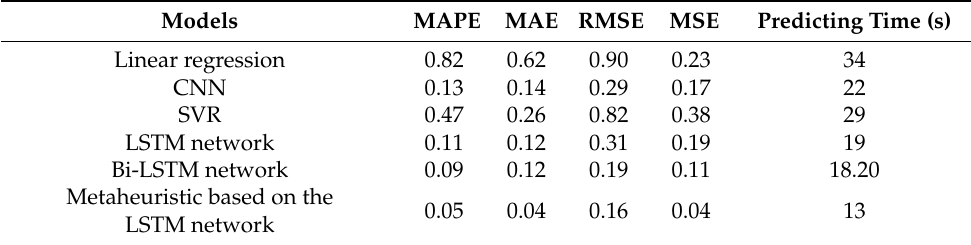
Table 5. Performance of the experimental models on IHEPC